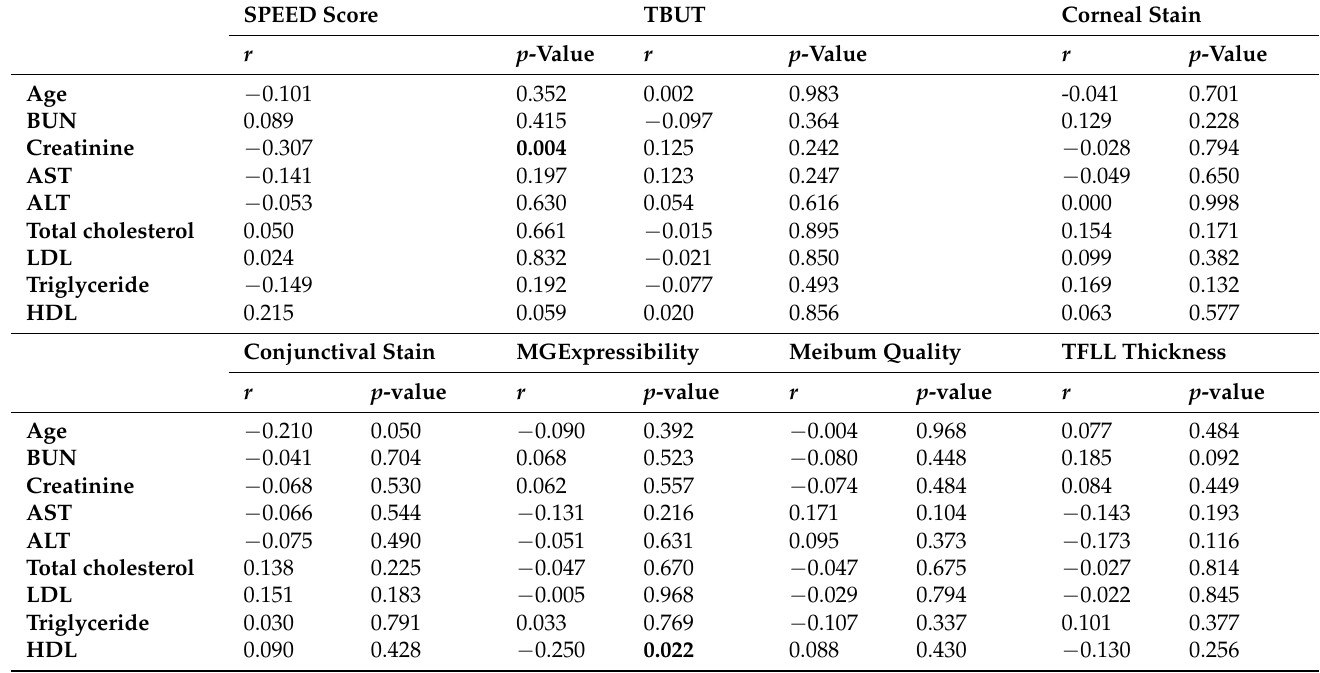
Table 2. Pearson’s correlations between DED/MGD parameters with continuous covariates.